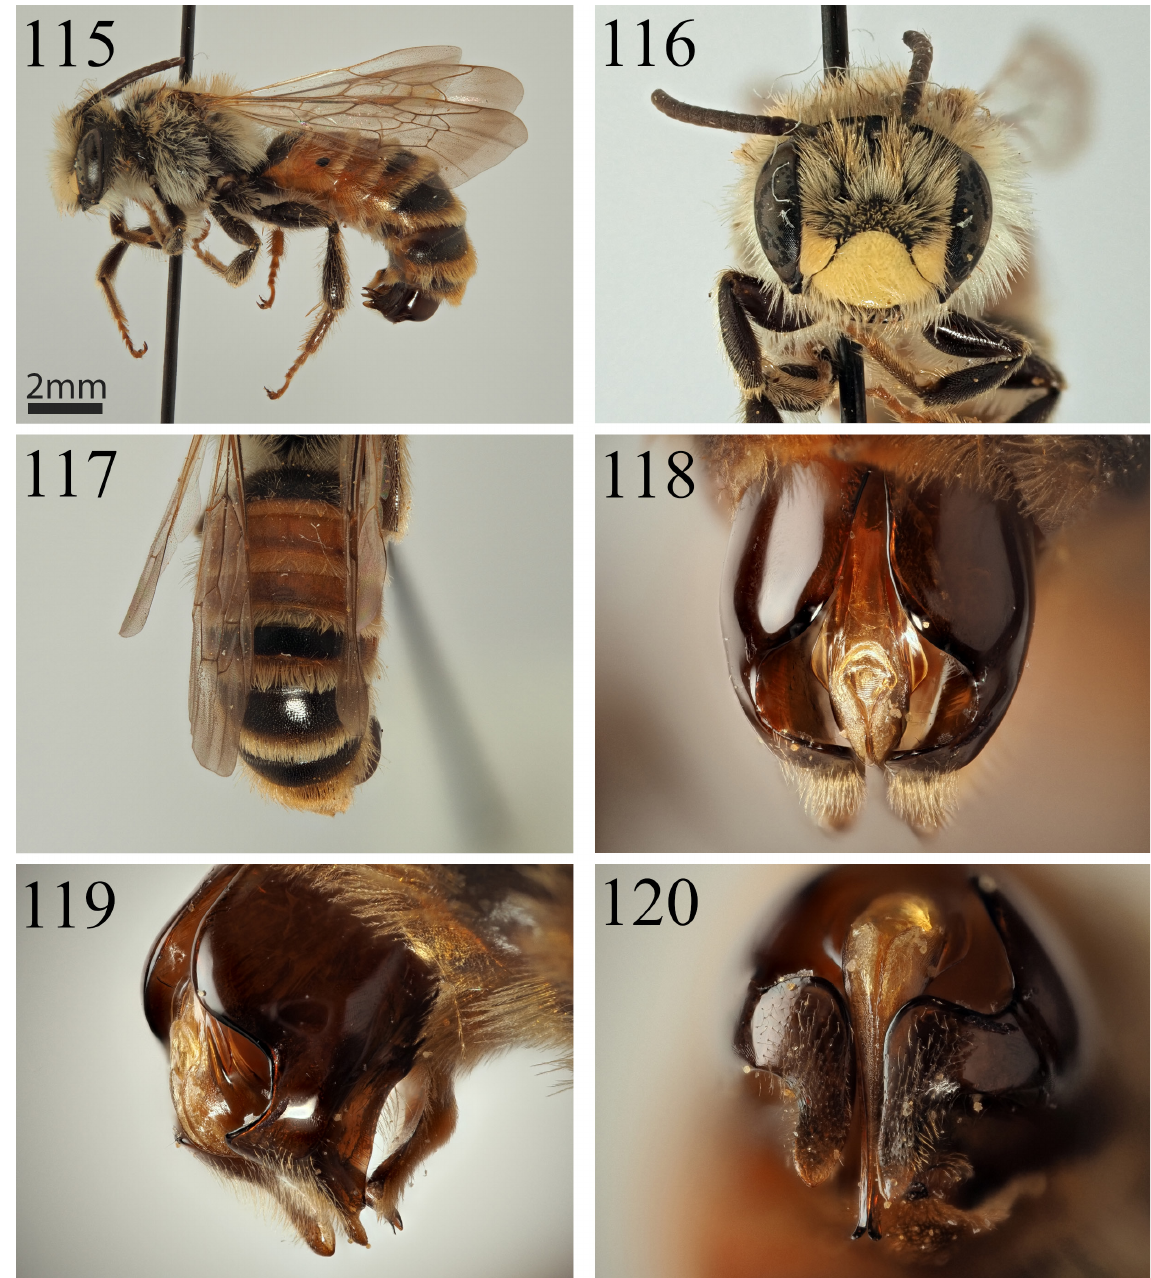
Figs 115–120. Andrena bulbosa Wood sp. nov., ♂ (OÖLM). 115 . Profile. 116 . Face. 117 . Terga. 118 . Genitalia dorsal view. 119 . Genitalia lateral view. 120 . Genitalia ventral